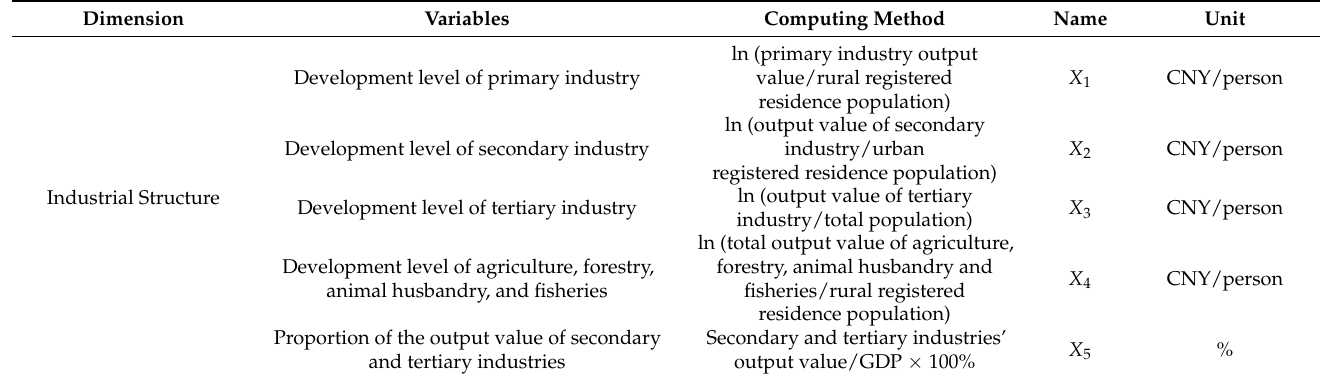
Table 1. Index system and calculation method of the influencing